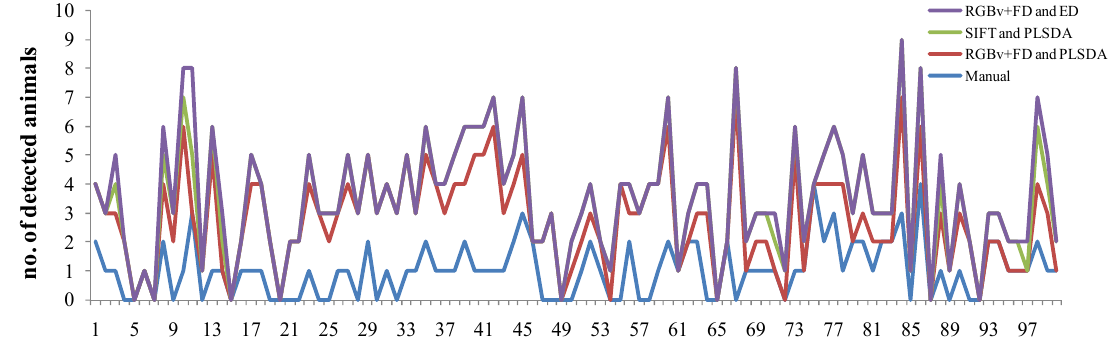
Figure 7. Time series of manually and automatically counted squat lobsters ( Munida quadrispina ) in digital images taken at the VENUS cabled observatory. The outputs of the three different automated methods (RGB+FD and PLSDA; SIFT and PLSDA; RGB+FD and ED3; see Figure 1) were graphed in relation to output generated by manual